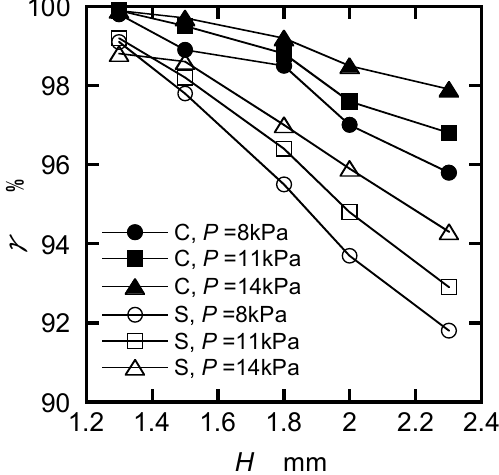
Fig. 9 Maximum turbulence intensity of the downward air jet ( y = 1.5 mm) for various pressures in the air storage chamber